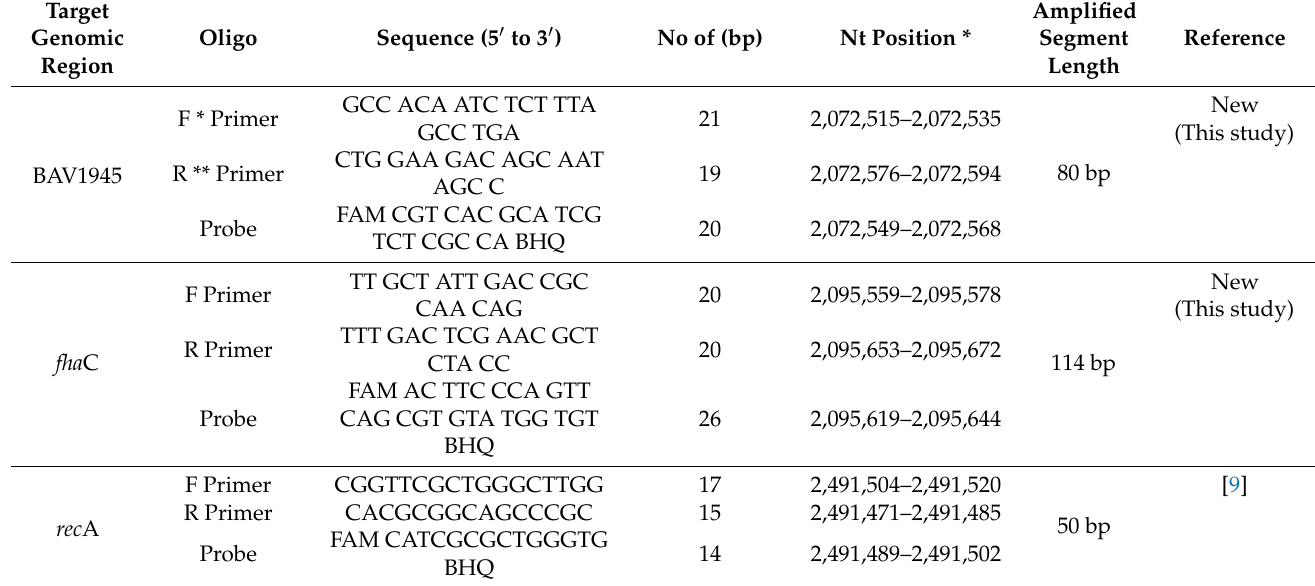
Table 2. Genomic targets and oligonucleotides characteristics of the three BA TaqMan qPCR assays included in this study. Target Genomic